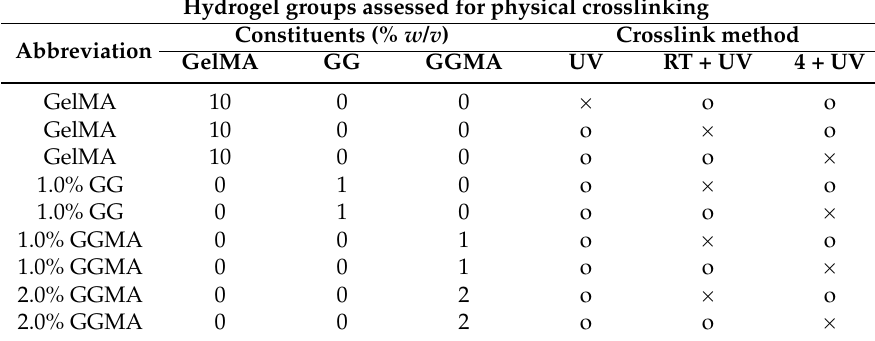
Table 2. Summary of hydrogel groups used to test the effects of physical crosslinking prior to chemical crosslinking through ultraviolet (UV) radical polymerization. All gels were mixed with NaCl + mannose. GelMA = gelatin methacrylamide; GG = gellan gum; GGMA = gellan gum methacrylate. UV = immediate UV crosslinking; RT + UV = 20 min physical crosslinking at room temperature (RT) prior to UV crosslinking; 4 + UV = 10 min physical crosslinking at 4 ˝ C prior to UV crosslinking. UV-only group was not included in the GG/GGMA comparisons as GG cannot be UV crosslinked. Crosslink method groups are indicated by either “o” (included) or “ ˆ ” (excluded).